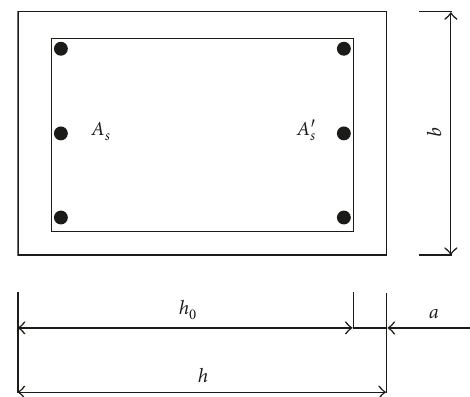
Figure 2: Symmetrically reinforced rectangular cross section.